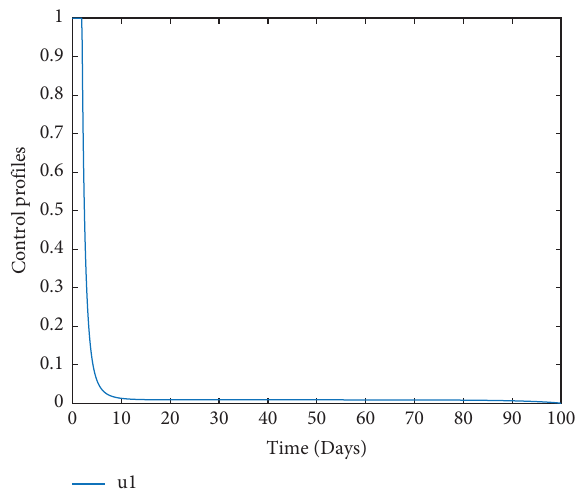
Figure 10: Diagram of the optimal solution u ∗